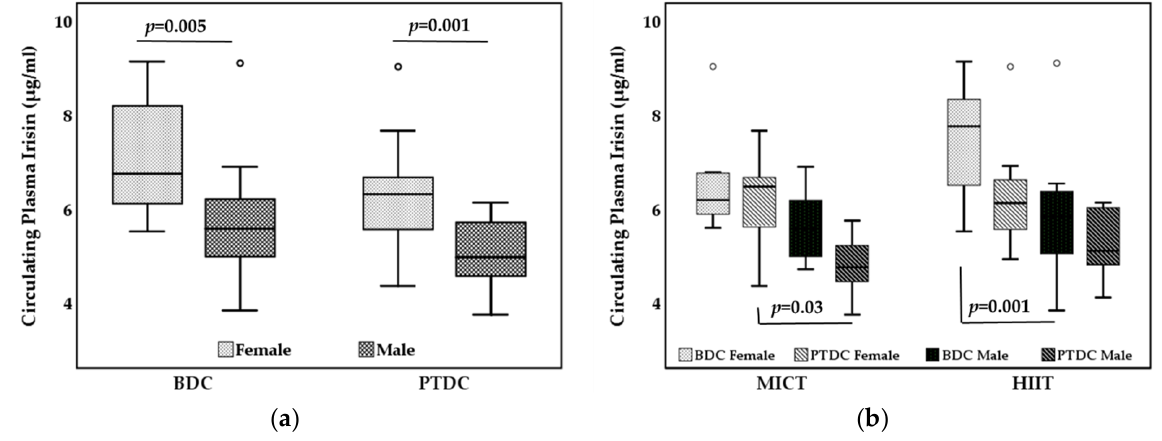
Figure 2. Sex-stratified circulating plasma irisin ( a ) before and after 12 weeks of training and ( b ) and stratified by interventional group. BDC, baseline data collection; PTDC, post training data collection; MICT, moderate-intensity continuous training; HIIT, high-intensity interval training.